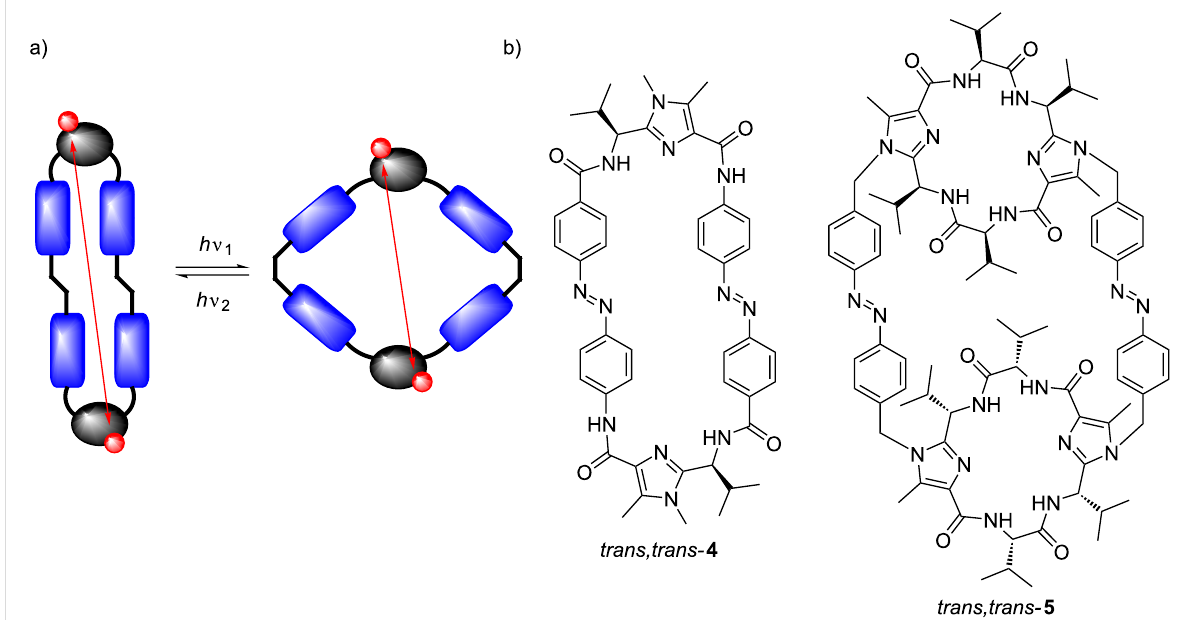
Figure 2: a) Principle of a chiral foldable platform and container based on Lissoclinum cyclopeptide alkaloids. b) Switchable molecular platform 4 and switchable molecular container 5 .